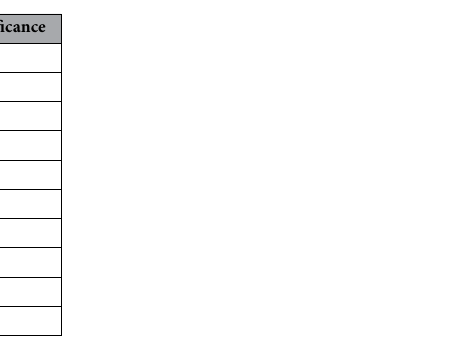
Table 4. Results of the generalized estimating equations model regarding the gender differences of the effect of eating (Method C). AED : antiepileptic drug; CI : confidence